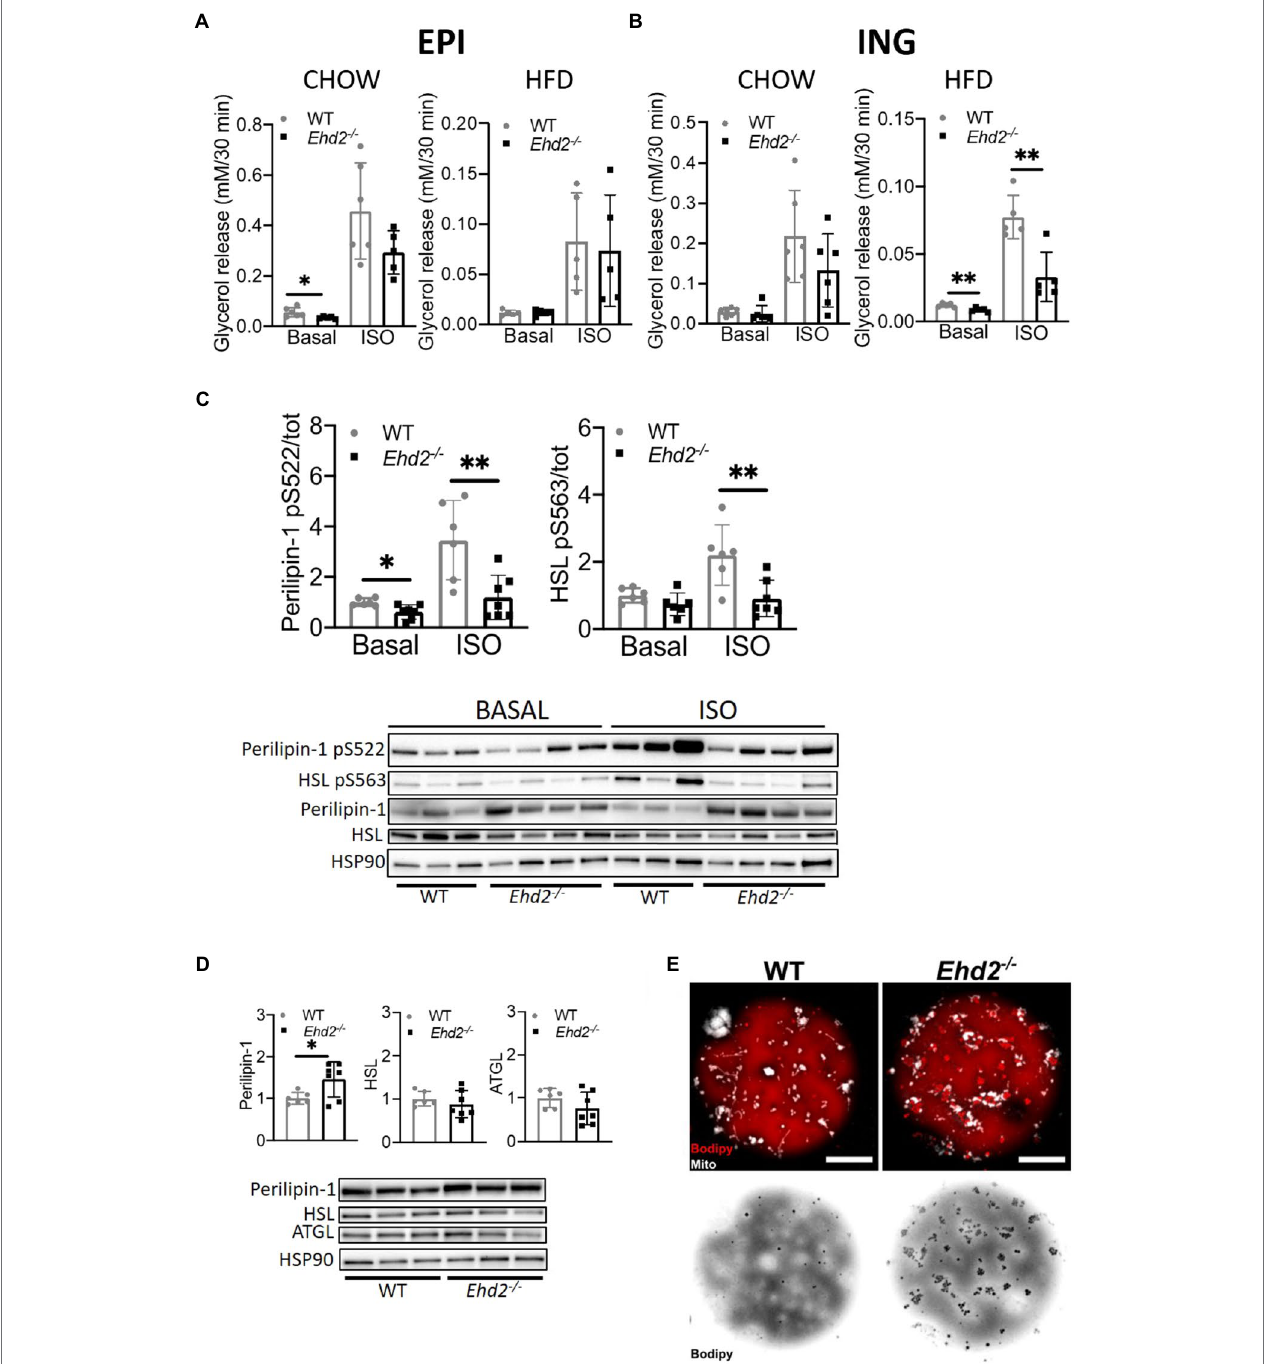
FIGURE 5 | Lipolysis in adipocytes isolated from Ehd2 − / − and WT mice. (A,B) Primary adipocytes were isolated from EPI or ING depot, and cells in suspension were subjected to non-stimulation (basal) or β adrenergic stimulation using isoprenaline (ISO; 10 nM) for 30 min. Lipolysis was measured as release of glycerol into the medium in a 10% (v/v) cell suspension. Basal and ISO stimulated lipolysis of EPI (A) and ING (B) adipocytes from chow and HFD fed mice ( n = 6 chow, n = 5 HFD). (C) Western blot showing total and phosphorylated levels of perilipin-1 pS522 and HSL pS563 from ING adipocytes from HFD-fed mice, either non-stimulated or stimulated with isoprenaline (ISO; 30 min; n = 6-7/group), quantification shows phosphorylation over total protein. HSP90 used as loading control. (D) Western blot analysis displaying representative image and quantification of cell lysates from ING adipocytes after HFD-feeding. Total protein level of perilipin-1, HSL, and adipose triglyceride lipase (ATGL) from non-stimulated cells ( n = 3–4). (E) Confocal image of lipid droplet clusters in primary ING adipocytes from chow-fed mice. Cells were stained for lipids (bodipy, red) and mitochondria (mitotracker, white). Lower panel shows only lipids in inverted grayscale. Scale bar = 10 μ m. Data in (A–D) are presented as mean ± SD, and * p < 0.05 and ** p < 0.01 were calculated using two-tailed Student’s t